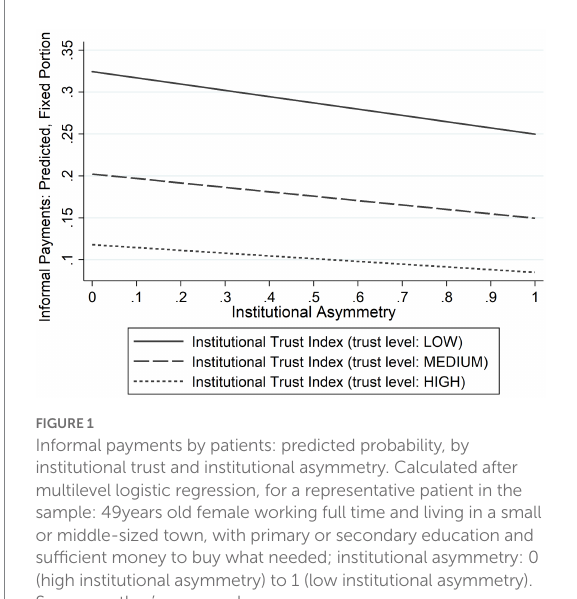
FIGURE 1 Informal payments by patients: predicted probability, by institutional trust and institutional asymmetry. Calculated after multilevel logistic regression, for a representative patient in the sample: 49 years old female working full time and living in a small or middle-sized town, with primary or secondary education and sufficient money to buy what needed; institutional asymmetry: 0 (high institutional asymmetry) to 1 (low institutional